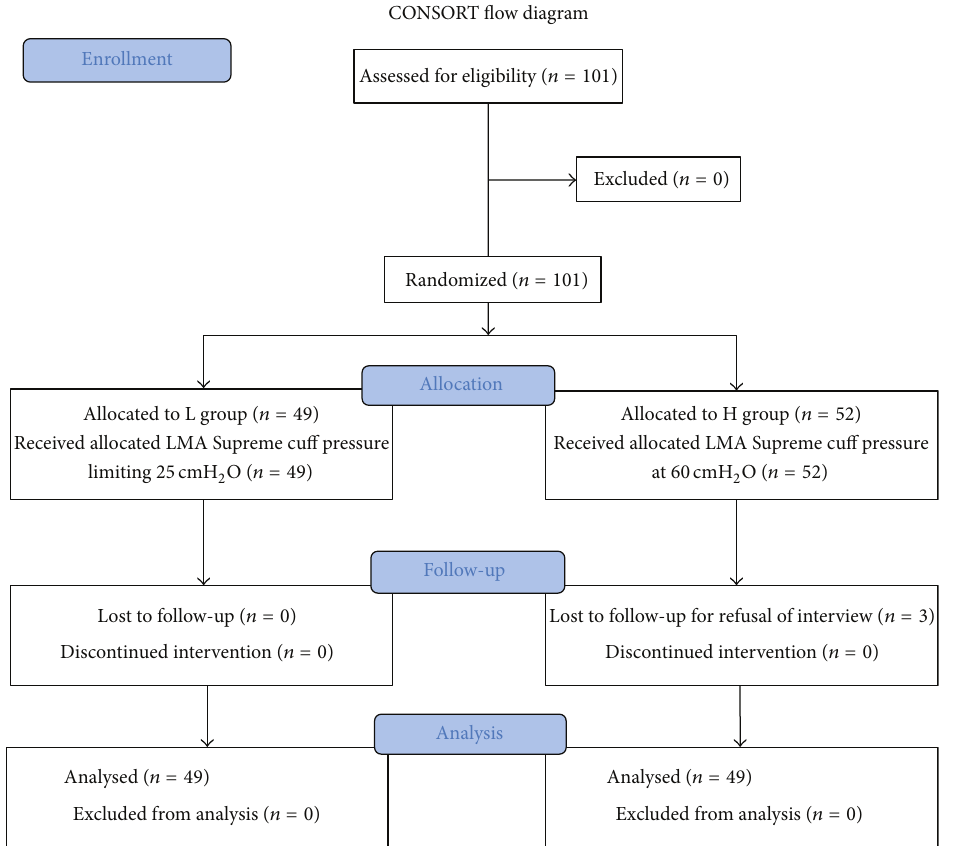
Figure 1: CONSORT flow diagram. LMA: laryngeal mask airway; L group: laryngeal mask airway (LMA) cuff pressure limiting 25 cmH 2 O group; H group: LMA cuff pressure at 60 cmH 2 O